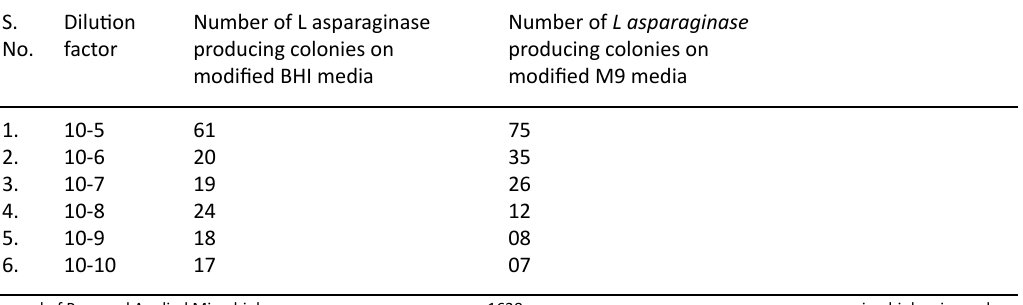
Table 1. Number of colonies producing L asparaginase enzyme in modified BHI and M9 media